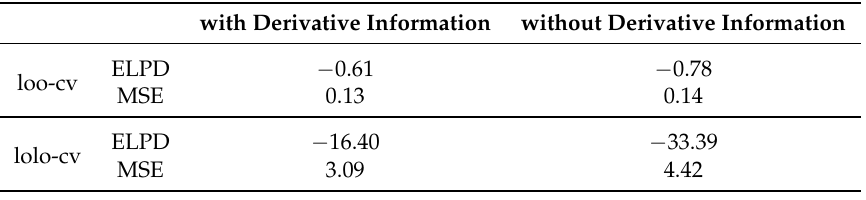
Table 3. ELPD and MSE for both models, with and without derivative information, computed by the two cross-validation schemes, loo-cv and lolo-cv.